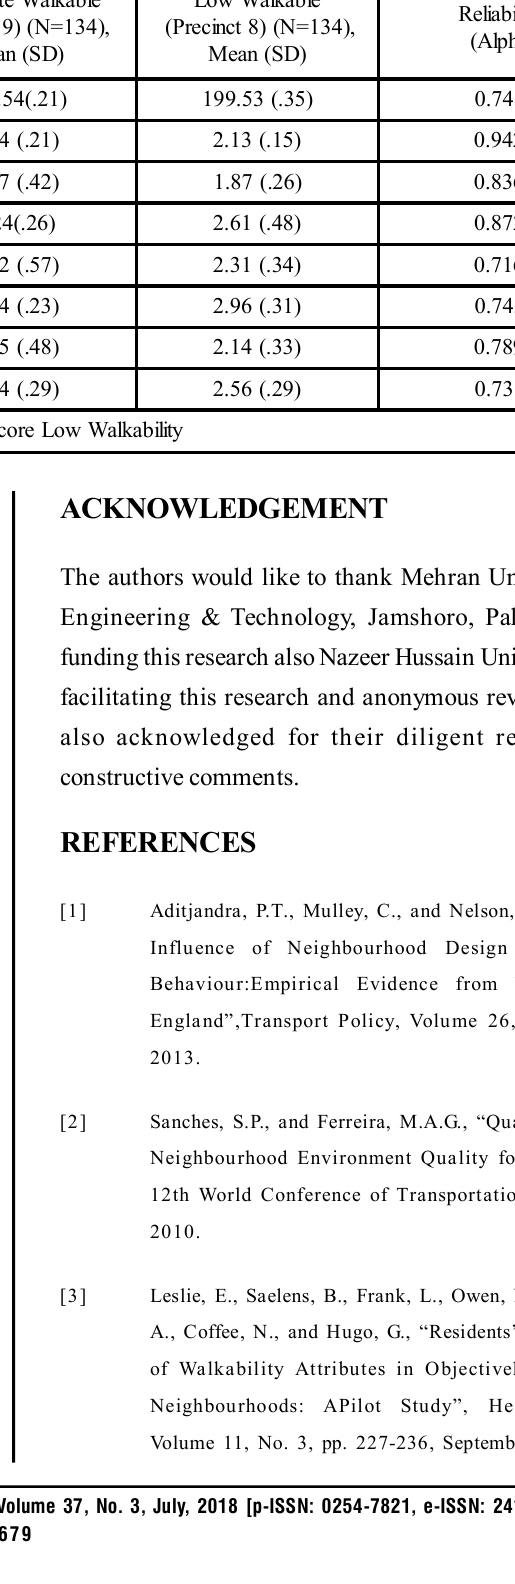
TABLE 3. MEAN AND STANDARD DEVIATION SUBSCALE SCORES FOR DIFFERENT LEVEL OF WALKABILITY Perceived Neighbourhood\ Built